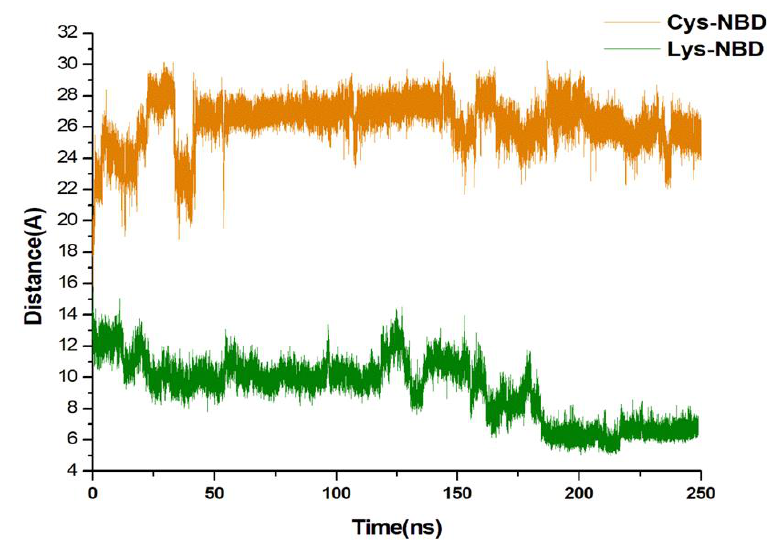
Figure 9. Distance between C- α residues involving THR265, and ASN57 α-helices of the NBD. The average distances were found to be 9.24 Å and 26.14 Å , respectively, for Lys-NBD and Cys-NBD conformations.